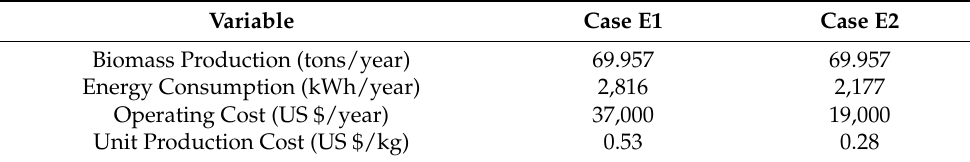
Table 5. Summary of Results for the Drying stage (Spray Dryer and Drum